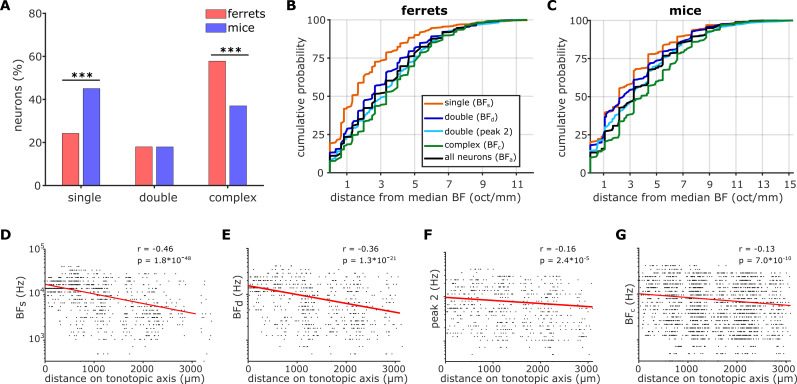
Effects of FRA complexity on BF organization hold across all imaged neurons.(A) Proportion of neurons in each FRA class are shown for ferrets (red) and mice (blue), classified as in Figure 5C. The results of Likelihood Ratio tests are indicated above (*** p < 0.001). (B) Cumulative probability plots of the difference (octaves/mm) between the BF of each neuron imaged in ferrets and the median BF of all neurons in the same imaging field. Distributions were calculated separately for BFs (orange), BFd (dark blue), peak 2 of double-peaked neurons (light blue), BFc (green), and BFa (black). (C) Results plotted as in B, but for all neurons imaged in mice. (D-G) Global tonotopic gradients in ferrets, presented as in Figure 4C. BFs (D), BFd (E), peak 2 (F), and BFc (G) of individual neurons (black dots) are plotted against the neuron’s position along the tonotopic axis. Red lines show the best single-term exponential fits to the data, and Pearson’s correlations (r) with their p-values (p) are given in the top right corner of each plot.